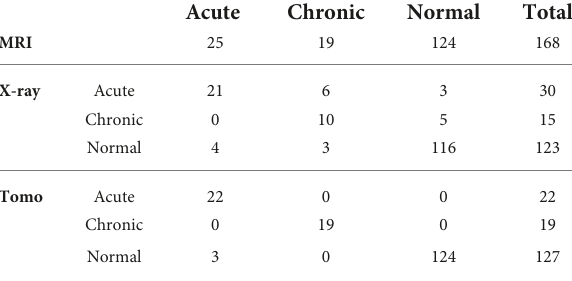
TABLE 2 Comparison of the performance of X-ray and tomosynthesis in diagnosis with